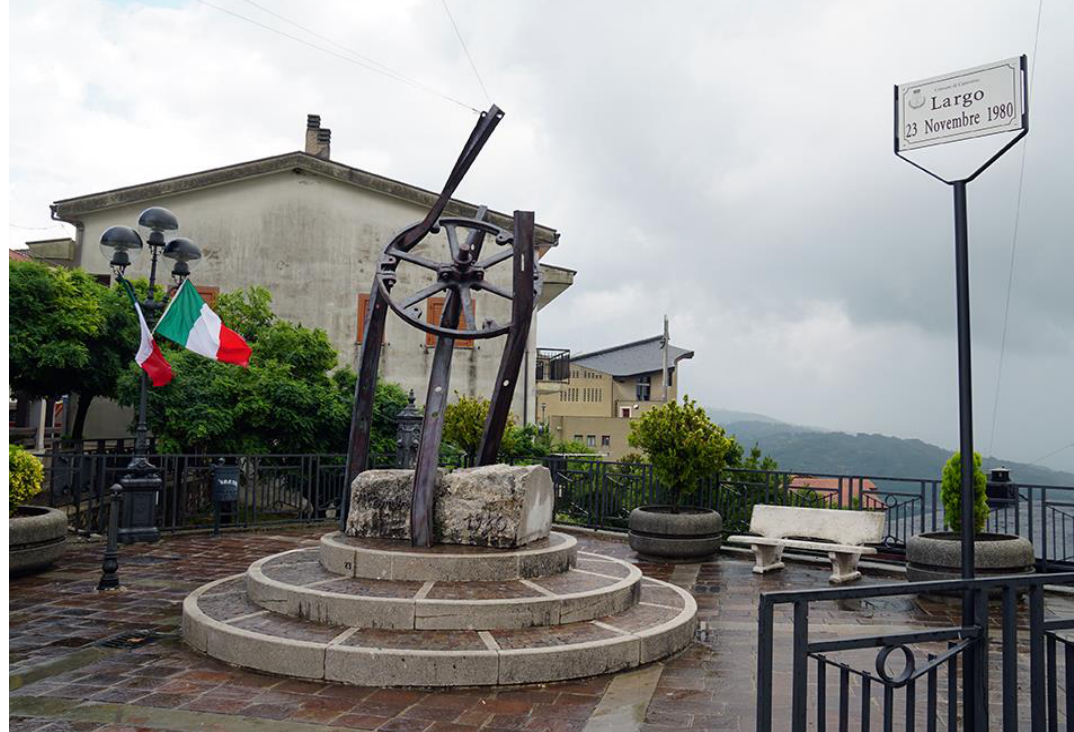
Figure 50. Calabritto: “Largo 23 November 1980”—Memorial dedicated to the earthquake victims (photos by [35,36]).